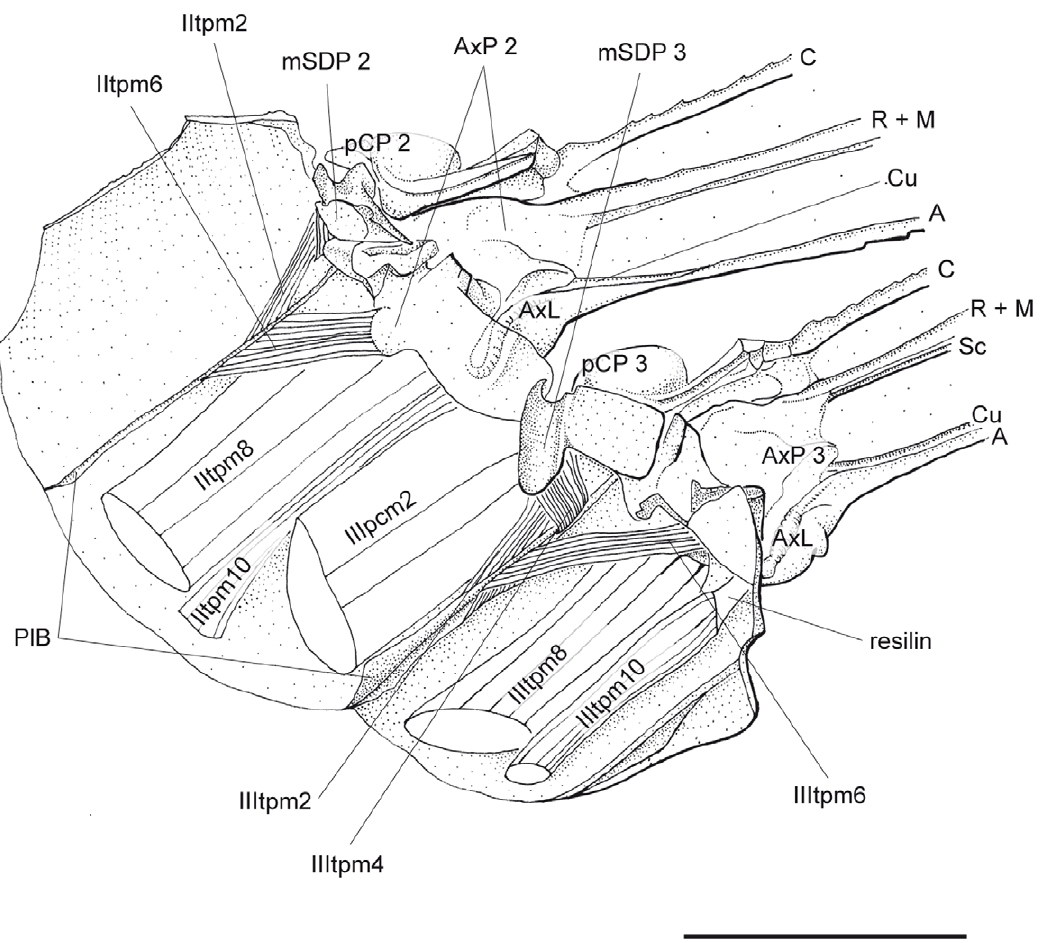
Figure 5. P.nymphula , detail of dorasl area of lateral flight musculature, longitudinal section, right. Abbreviations: A – anal vein, AxL – axillary ligament, AxP – axillary plate, C – costa, Cu – cubitus, M – media, mSDP - mediane semi-detached scutal plate, pCP – proximale costal